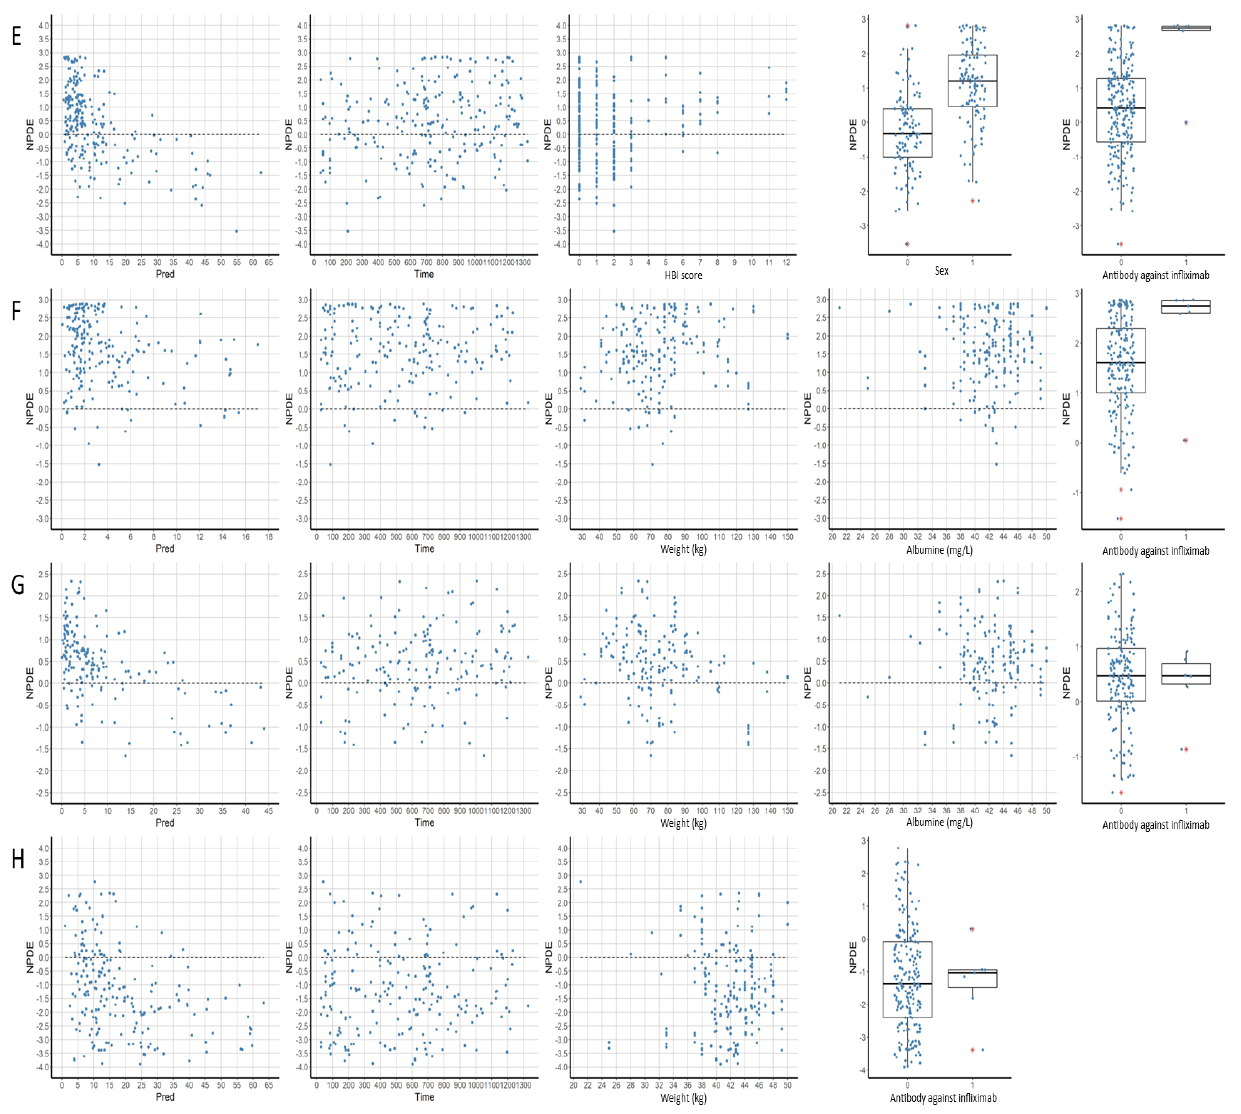
Figure 4. Evolution of NPDEs according to population predictions, time, and main covariates for the 8 evaluated models ( A – H ). Pred: population predictions, Sex: 0 = female and 1 = male except for model E.